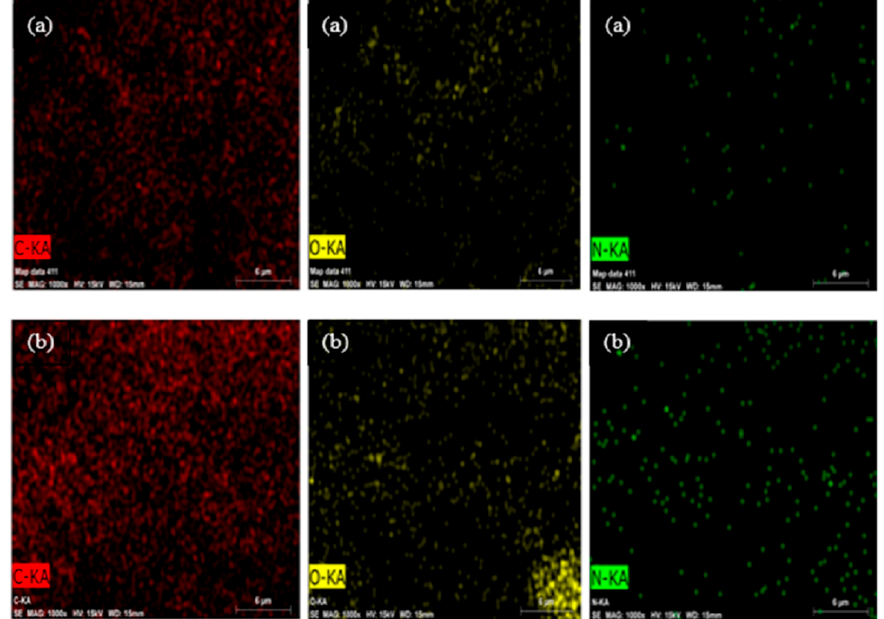
Figure 4. Elemental mapping images of MOGN ( a ) and DOX–MOGN ( b ).